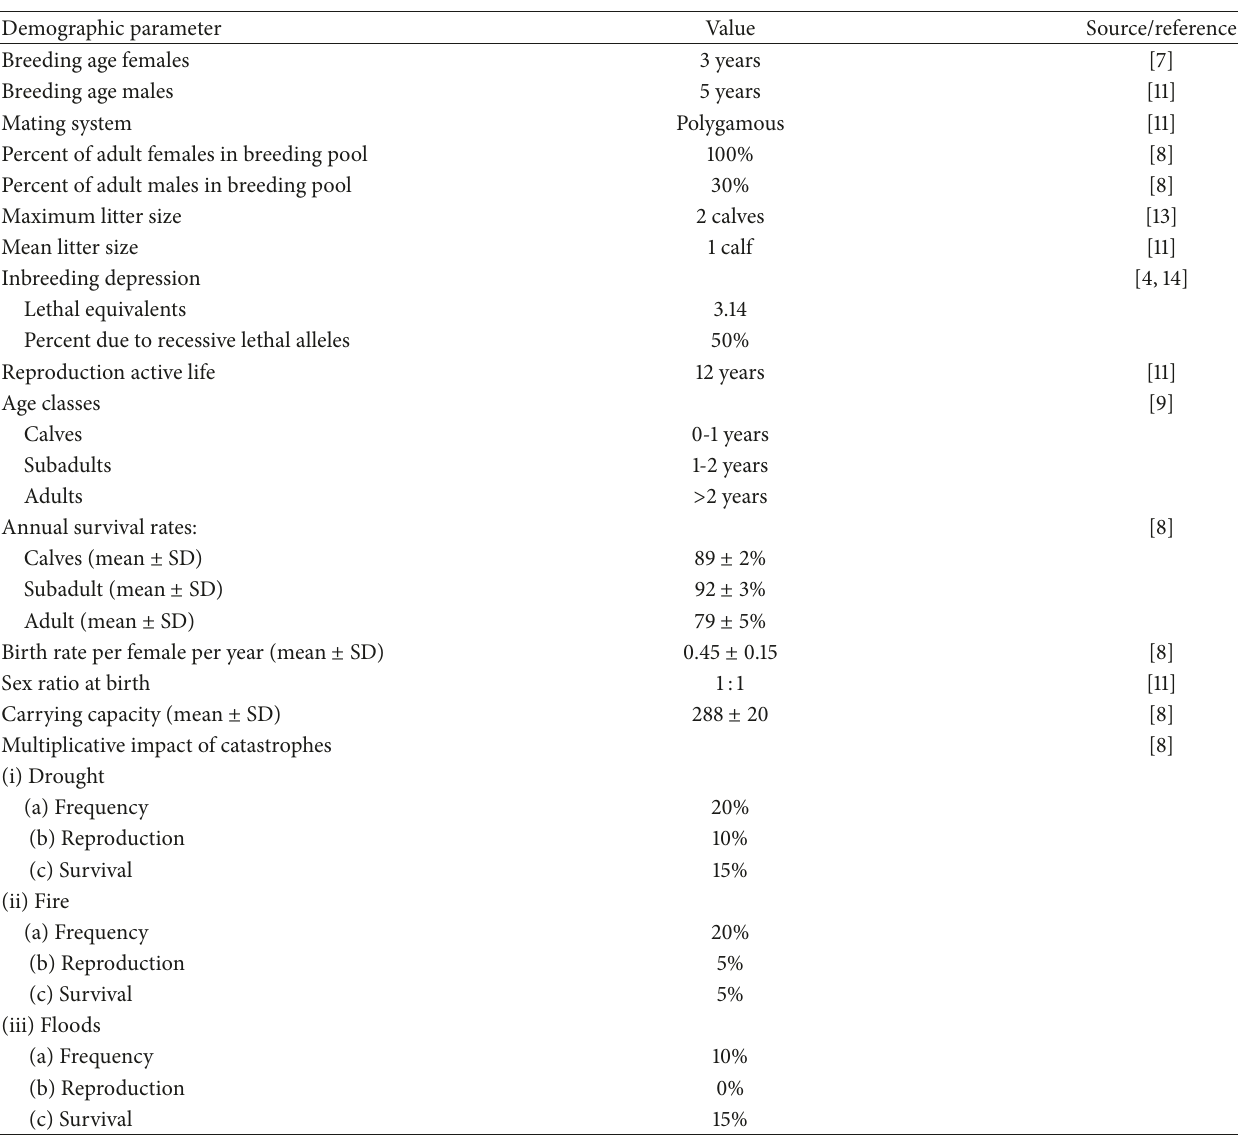
Table 1: Biological and ecological attributes of roan antelopes used as input data in the baseline scenario to the VORTEX model. The percentage impact of catastrophes (drought, fire, and floods) indicates how much the reproduction, survival, or frequency is reduced from what typically it should